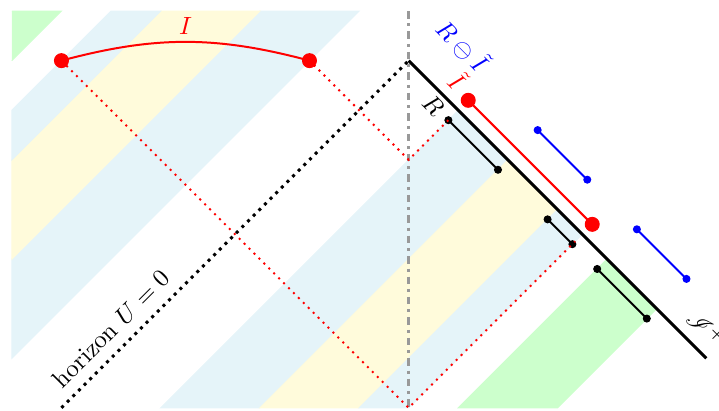
Figure 1 . An example where R consists of 3 intervals and an island with I shown as the red interval behind the horizon (actually very close to the horizon) and its mirror ‘island in the stream’ at I + . The coloured bands represent different subsets of outgoing modes and their entangled partner modes behind the horizon in the same colour. The light blue modes do not contribute to S QFT ( R ∪ I ) because both out-going modes and their entangled partners are in R ∪ I . On the other hand, the yellow and green modes do contribute because only one of the out-going modes and their partners are in R ∪ I .